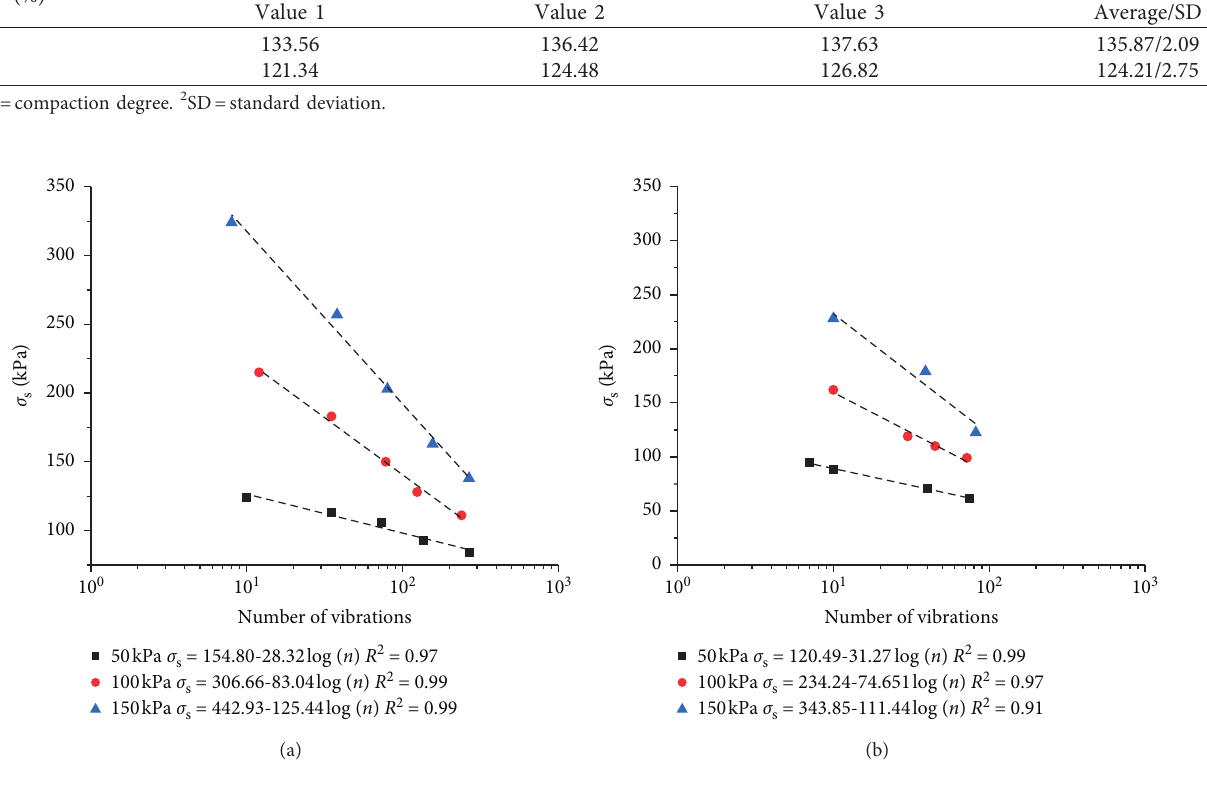
Figure 3: Dynamic strength of SOF. (a) Before F-T cycles. (b) After F-T